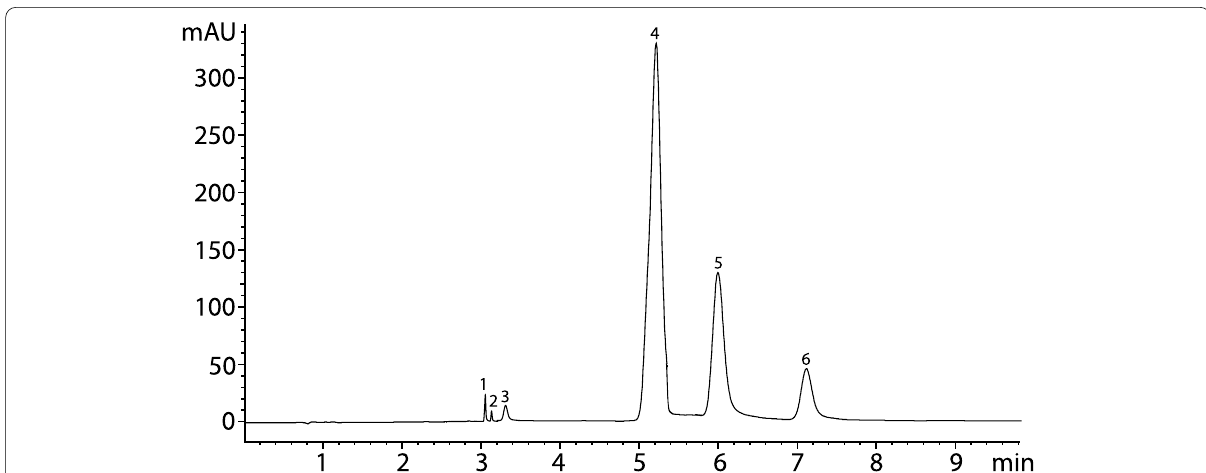
Fig. 4 HPLC chromatogram of the phenolic compounds of RBE: (1) catechin, (2) Gallocatechin gallate, (3) Ellagic acid, (4) Ferulic acid, (5) p -coumaric acid, (6) vanillic acid (means of three samples standard deviation, mg/kg RBE powder) ±